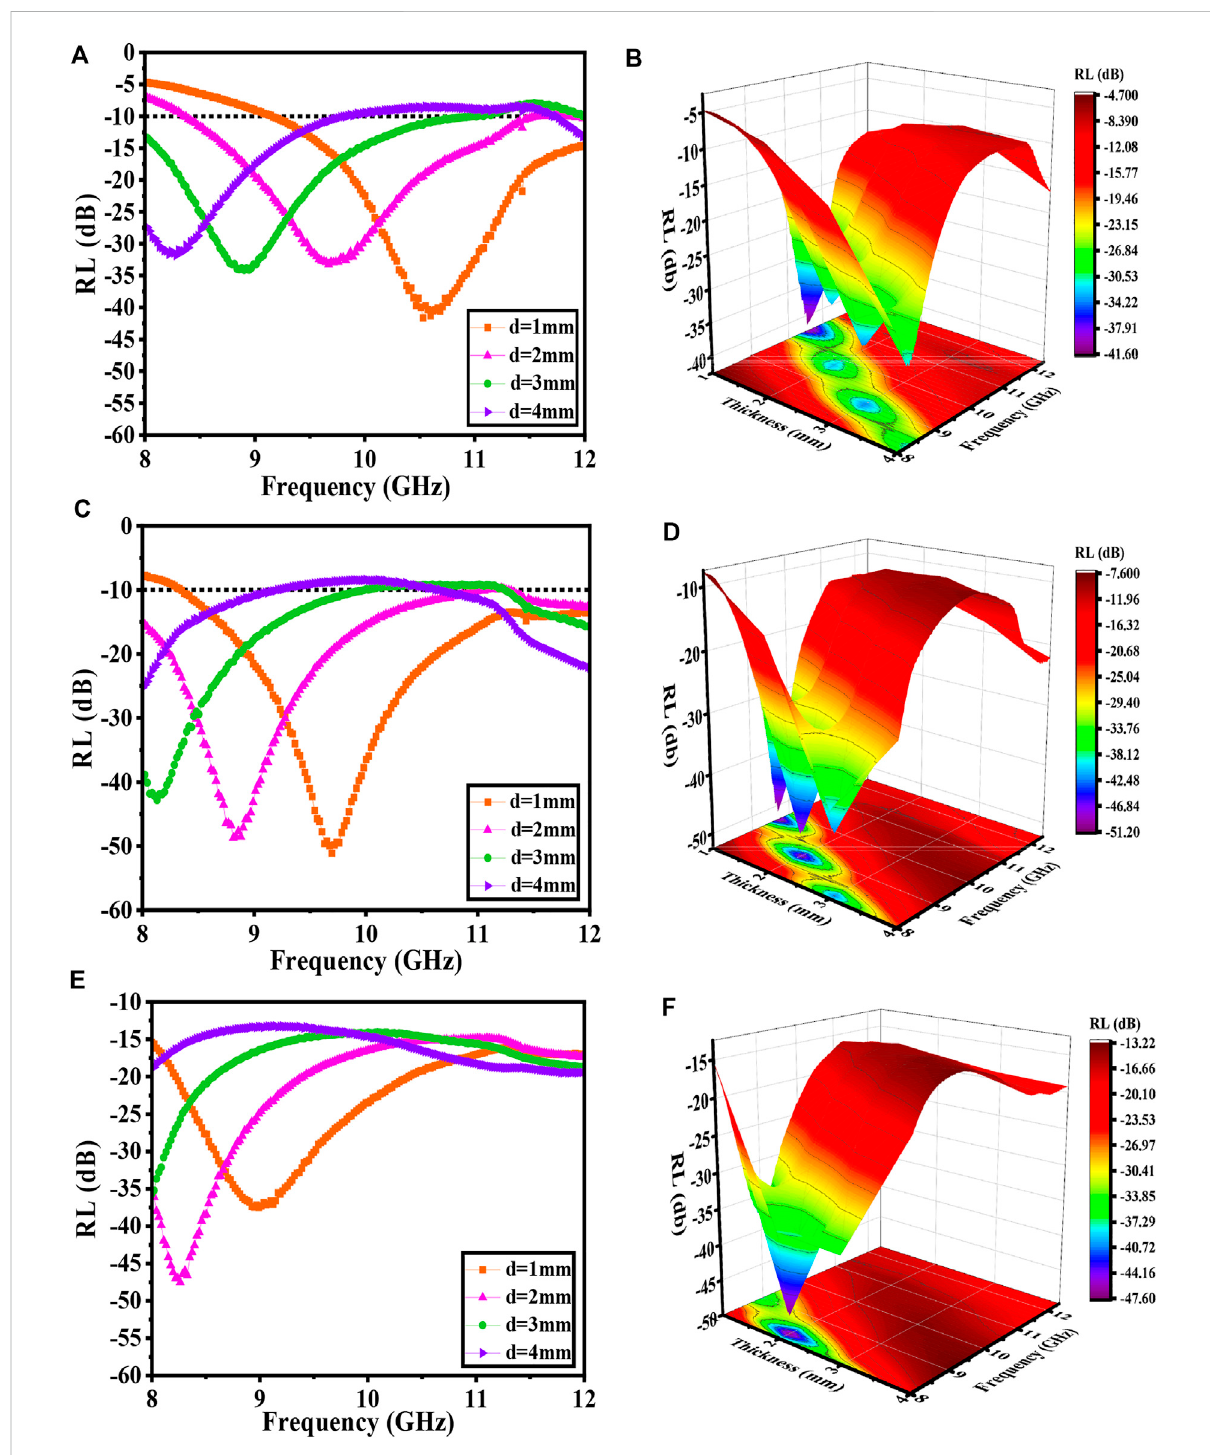
FIGURE 7 Frequency-dependent RL curves and three-dimensional contour maps of AC-25% (A) and (B) , AC-50% (C,D) , and AC-75% (E,F) .